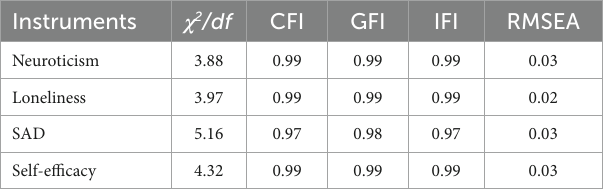
TABLE 1 Fit indices for measurement